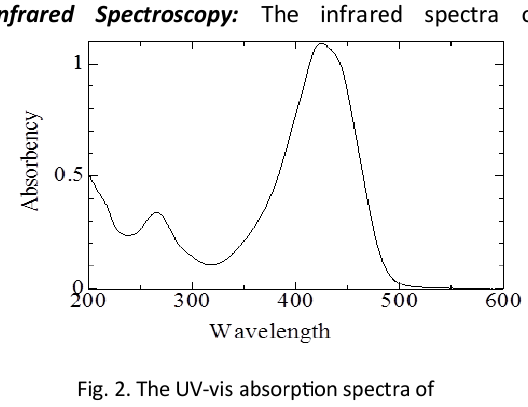
Fig. 2. The UV-vis absorption spectra